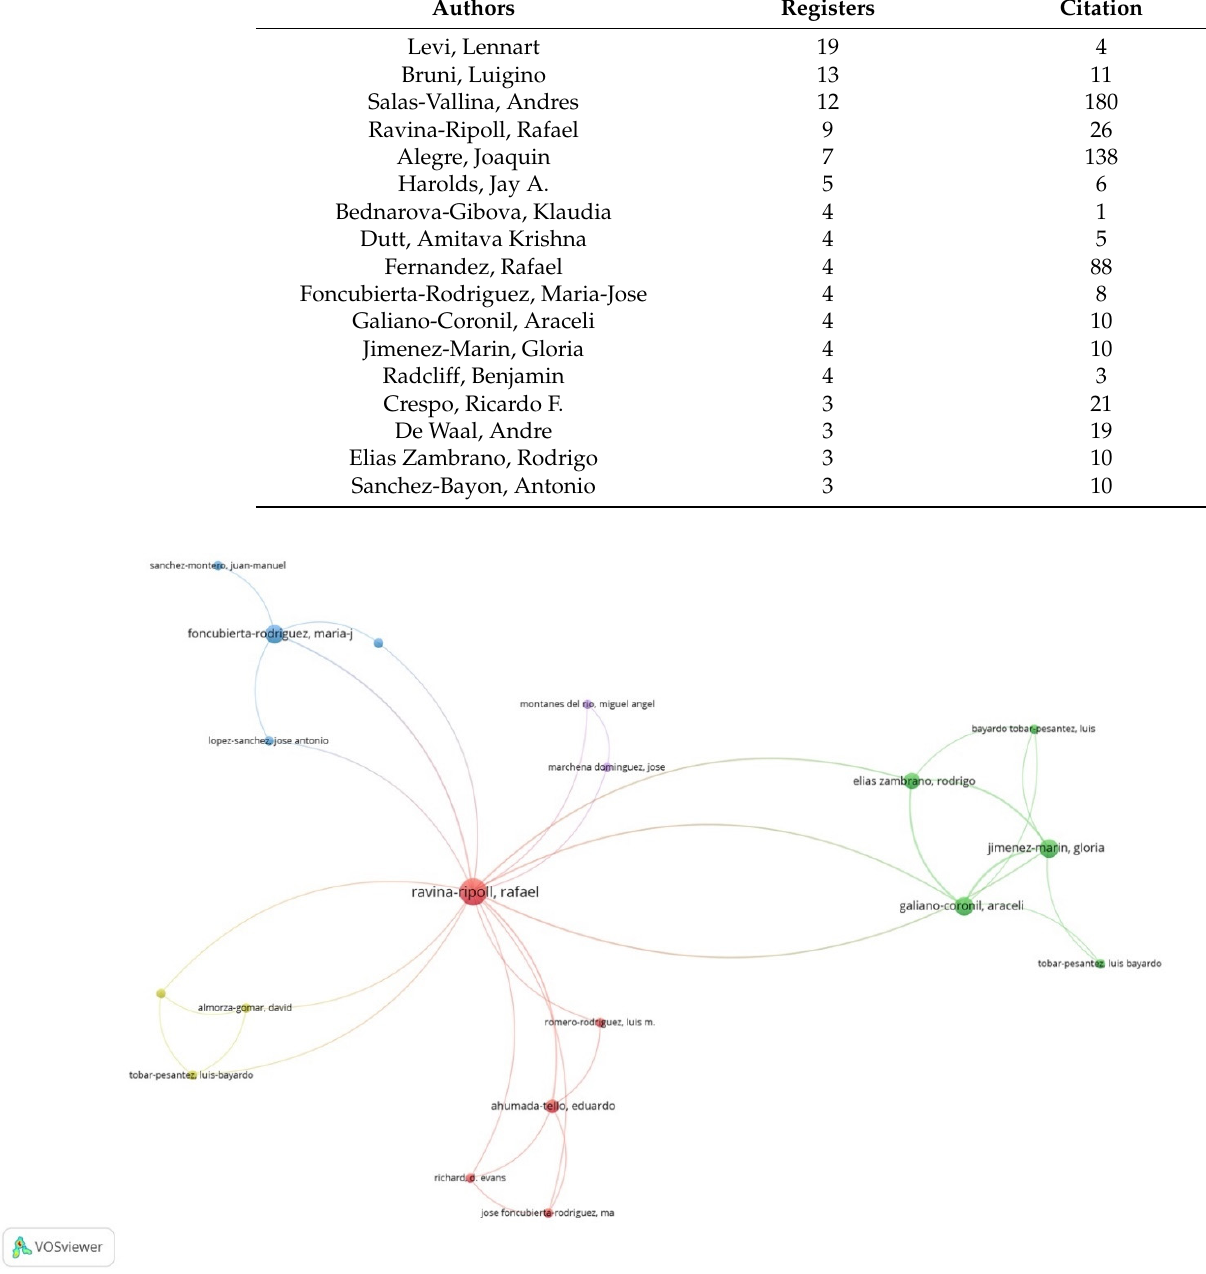
Figure 11. Interaction of most influential authors by papers and citations generated. Out of the 312 articles analyzed, the 10 with the highest numbers of citations are shown in Table 4. In this way, information was obtained about those works with the greatest dissemination (subject matter, typology, year of publication, etc.), their authorship, and the publications in which they are